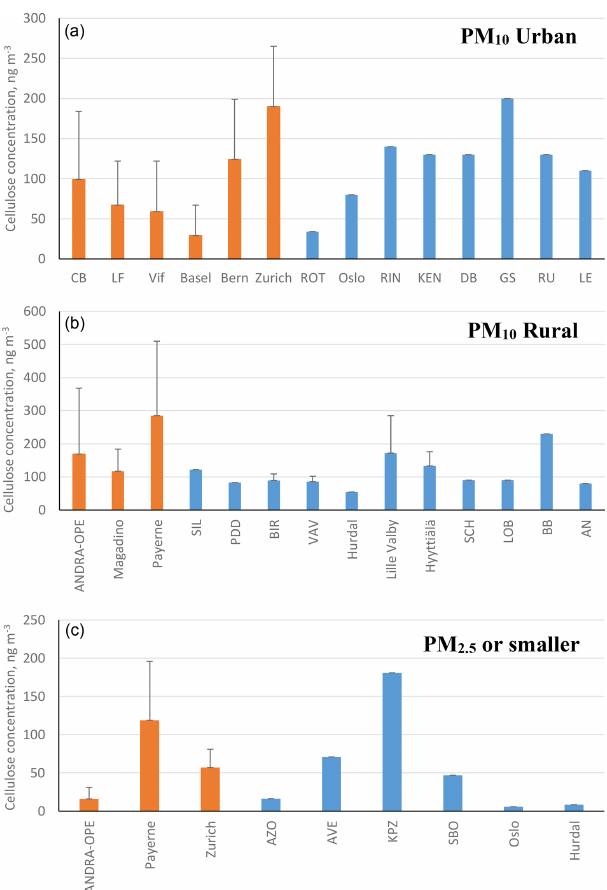
Figure 2. Annual cellulose concentrations (ngm − 3 ) reported within this study (orange bars) alongside previous literature mea- surements (blue bars). Black bars represent the standard deviation of the results. Bar charts are assigned as follows: (a) urban-based sites, (b) rural-based sites, and (c) PM 2 . 5 cellulose measurements (fine mode) or smaller. Note that only positive error bars are used for clarity. Literature sampling sites by country are the following. PM 10 urban: ROT (Netherlands); Oslo (Norway); and RIN, KEN, DB, GS, RU, and LE (Austria). PM 10 rural: SIL (Germany); PDD (France); BIR, Hurdal, and Hyyttiälä (Norway); Lille Valby and VAV (Denmark); and SCH, LOB, BB, and AN (Austria). PM 2 . 5 or smaller: AZO and AVE (Portugal), KPZ (Hungary), SBO (Austria), and Oslo and Hurdal